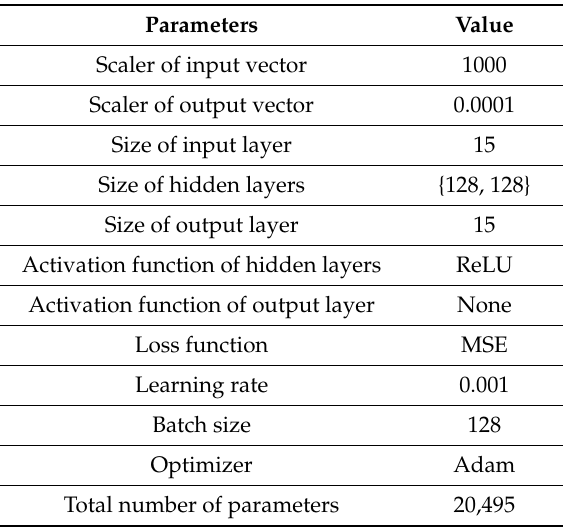
Table 1. Hyper-parameters of deep learning models.